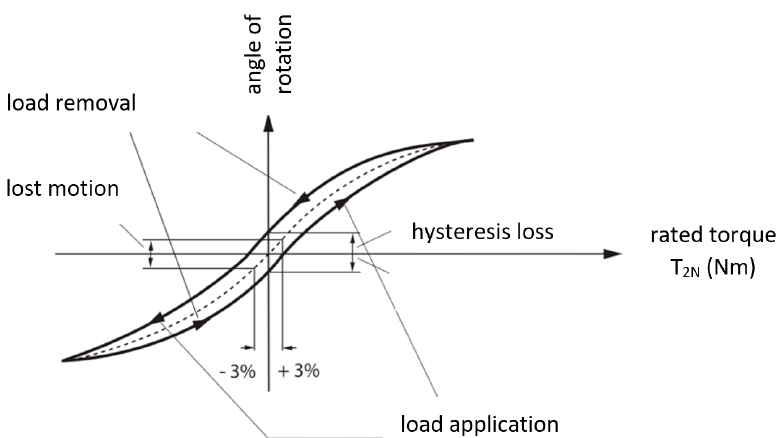
Figure 2. Hysteresis curve typical for Sumitomo Fine Cyclo/Spinea TwinSpin.